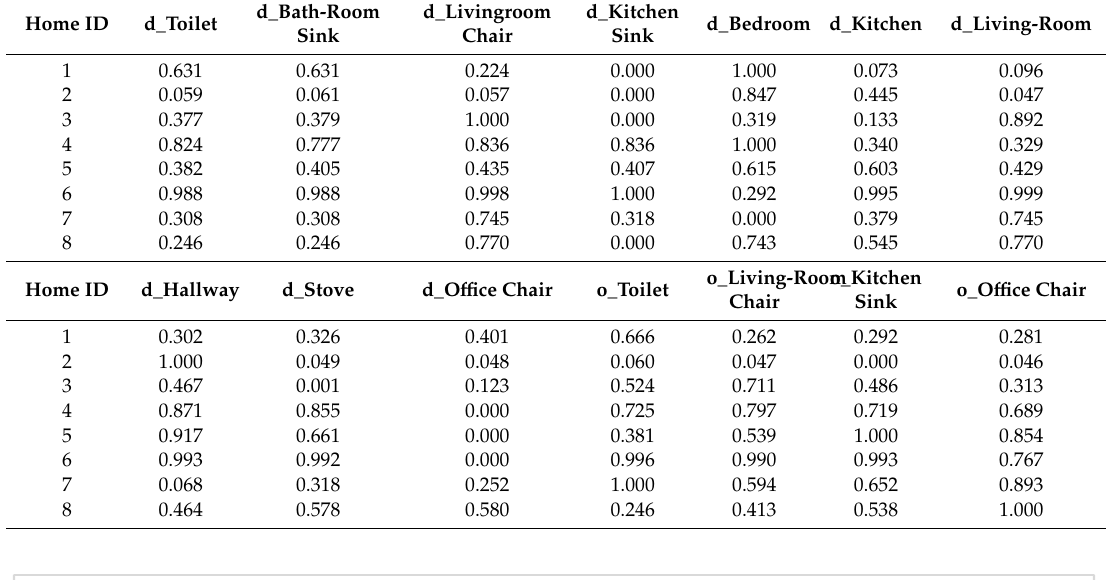
Table 4. Smart home normalized preference vectors.